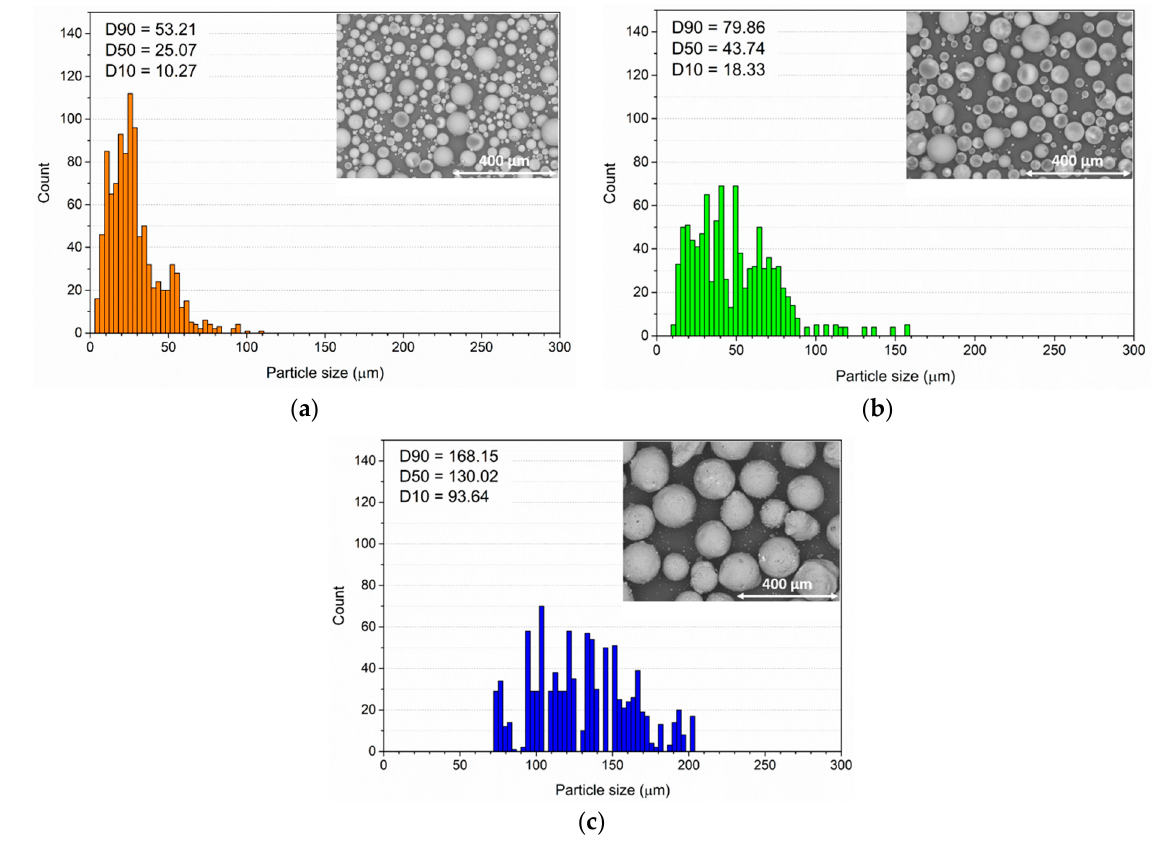
Figure 2. Evaluation of the glassy spheres’ dimensions carried out with ImageJ on ( a ) spheres C40, ( b ) spheres C15 and ( c ) spheres P. The pictures of the spheres were acquired by SEM (scale bar: 400 µm).